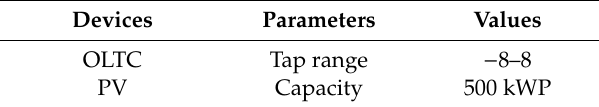
Figure 4. Modified PG&E 69-bus system with PVs. Table 2. The basic installation parameters of OLTC and PVs.